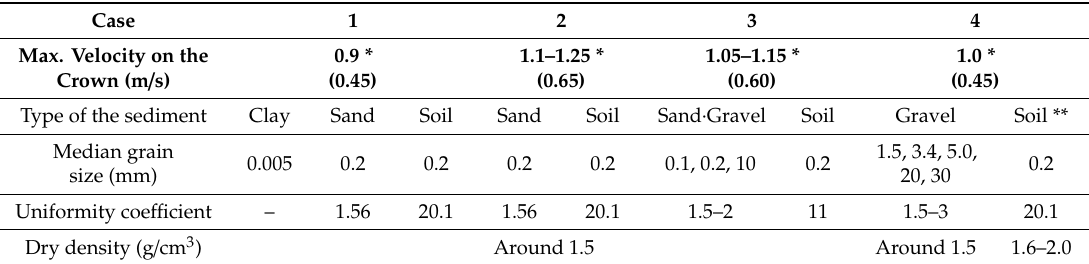
Table 1. Parameters of scouring experiments on the dike’s land side.